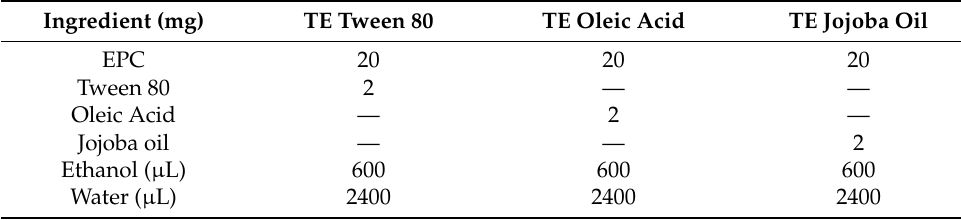
Table 1. The composition of